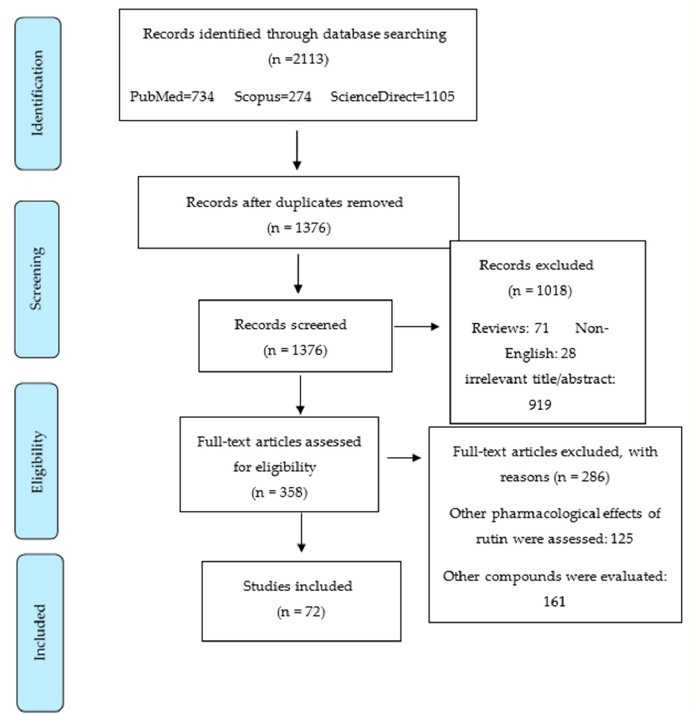
Figure 2. Flow diagram related to selection process of articles.